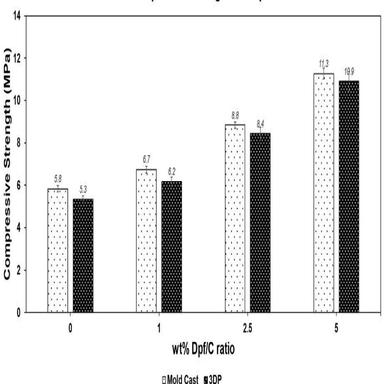
Bar graph depicting compressive strength of mold cast and 3DP structures with different ratios of Dpf/C.